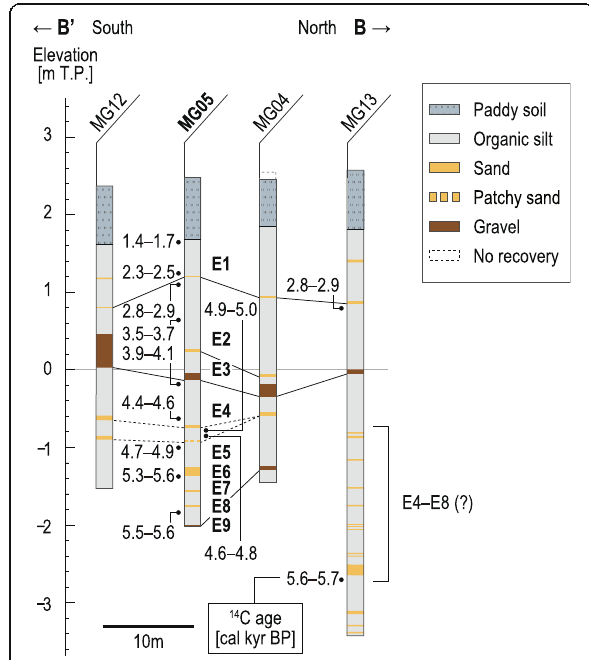
Fig. 3 Lithostratigraphy of the study site along transect B – B ′ in Fig. 1d. Radiocarbon ages are detailed in Table 2. The correlation of event deposits between core sites is shown by solid lines, with tentative correlations shown by dotted